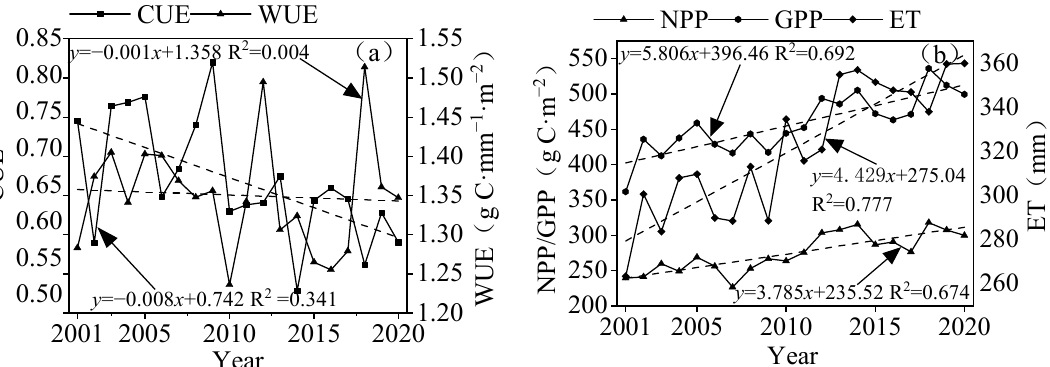
Figure 5. Trends of CUE, WUE, NPP, GPP, and ET in Inner Mongolia from 2001 to 2020. ( a ) Temporal trends of CUE and WUE. ( b ) Temporal trends of NPP, GPP, and ET.